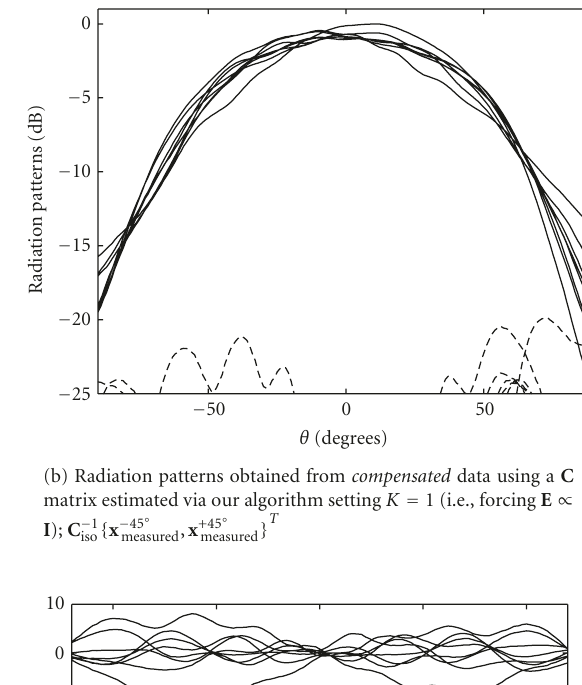
(c) Compensated radiation patterns using our method with K = 3;